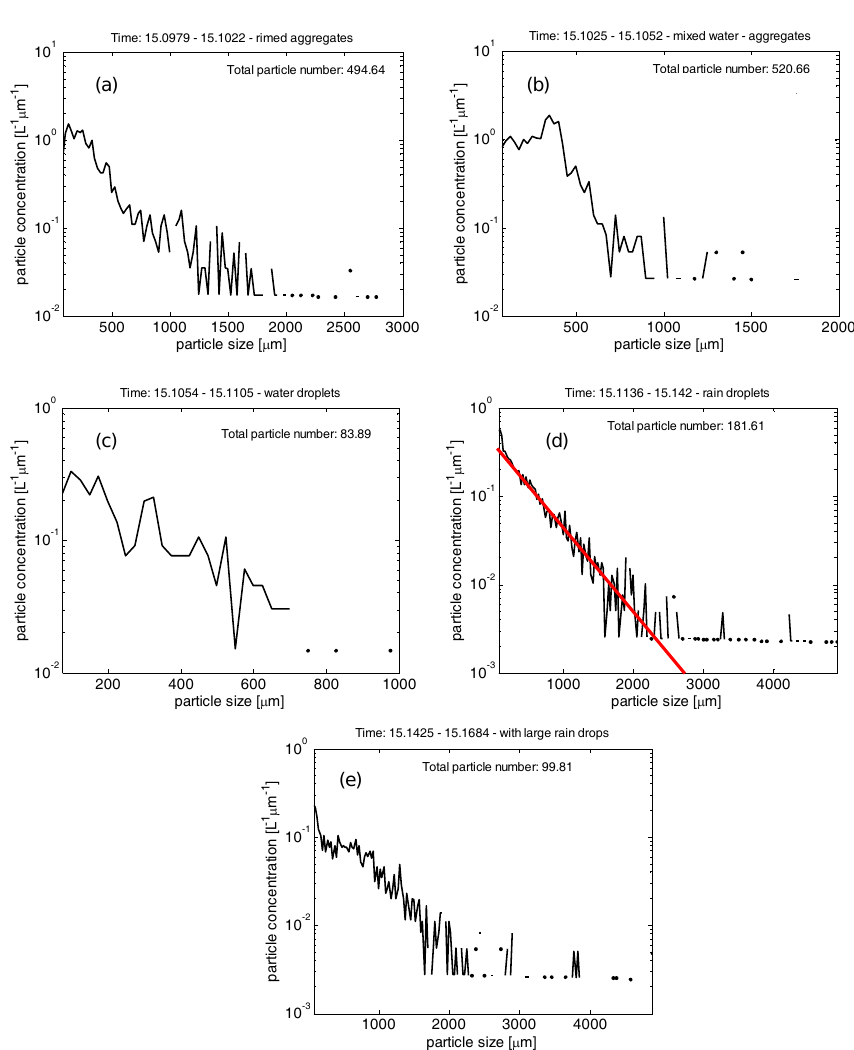
Figure 12. Precipitating particle size distribution as obtained from the time series of the two- 835 Fig. 12. Precipitating particle size distributions as obtained from the time series of the two-dimensional images. (a) : time interval “1” dimensional images. Panel (a): time interval “1” (15:05:52-15:06:07), panel (b): time inter- 836